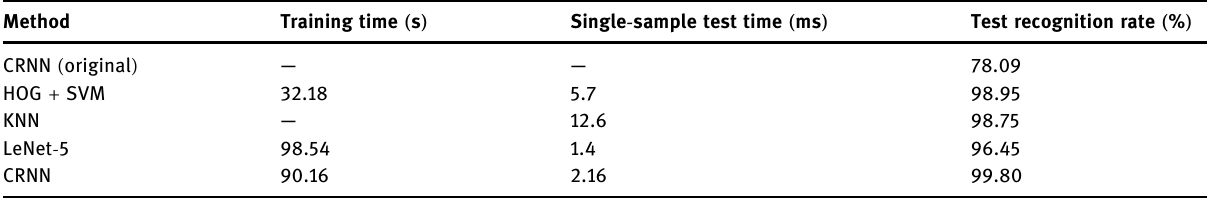
Table 2: Instrument character recognition